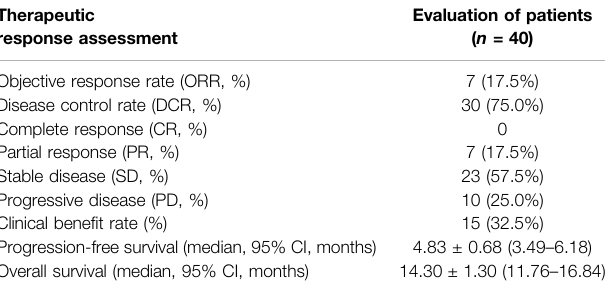
TABLE 2 | Therapeutic ef fi cacy of the response and survival outcome of patients treated with lenvatinib with the PD-1